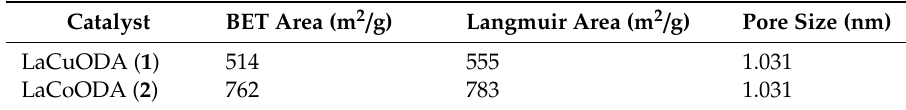
Table 2. Textural properties from CO 2 adsorption measures.